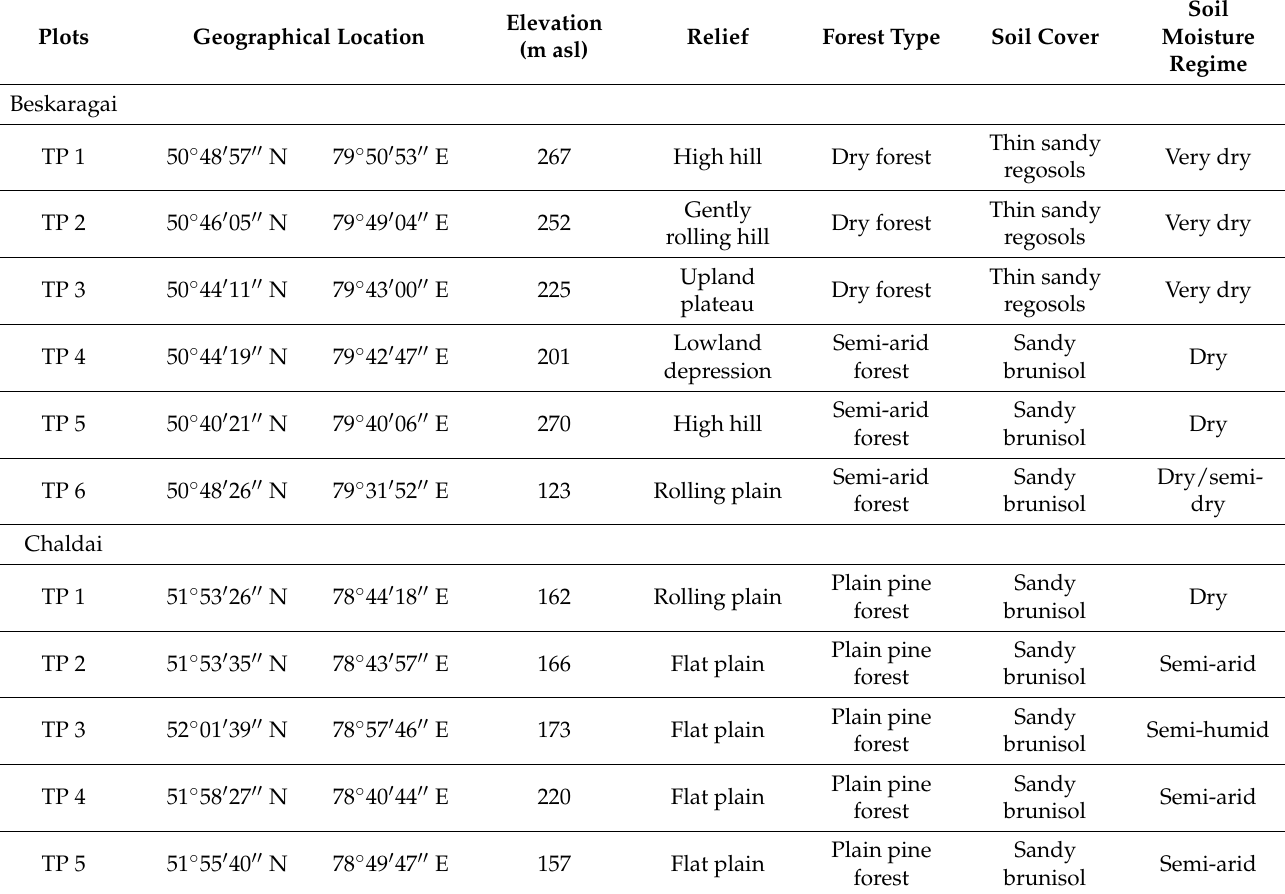
Table 1. Characteristics of the test plots of the regional geo-environmental